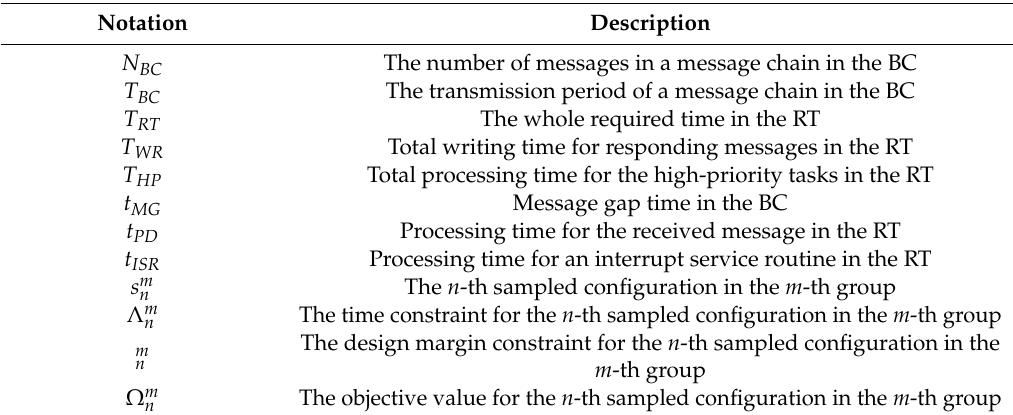
Table 1. The main notations in this